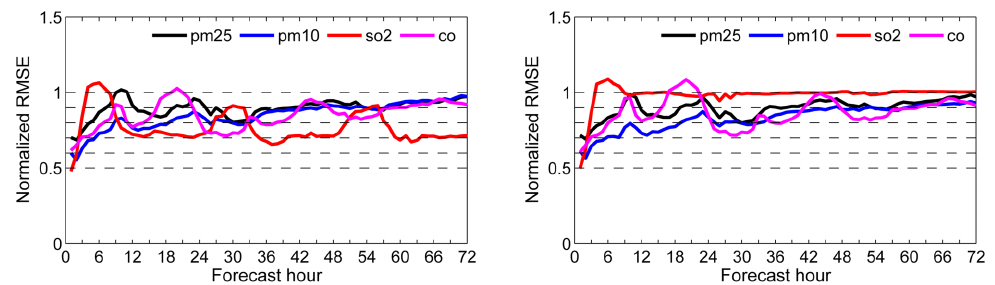
Figure 7. Normalized RMSE (assimilation divided by control) for fcICsEs and fcICs for PM 2 . 5 , PM 10 , SO 2 , and